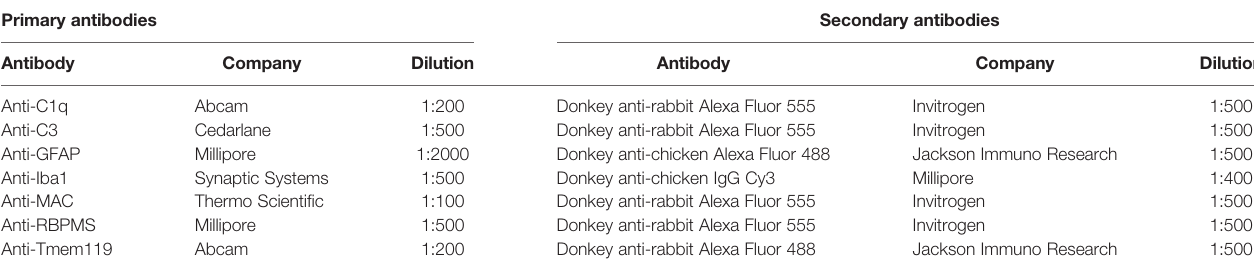
TABLE 1 | Primary and secondary antibodies used for immunohistochemistry on retina and optic nerve sections. Primary antibodies Secondary antibodies Antibody Company Dilution Antibody